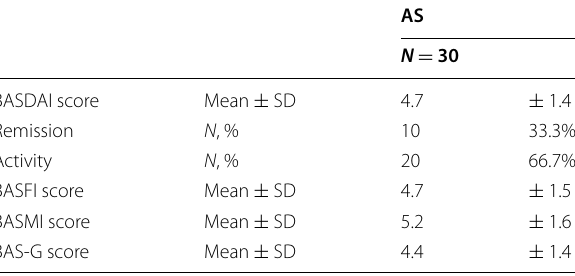
Table 2 Indices of disease activity and severity in all studied